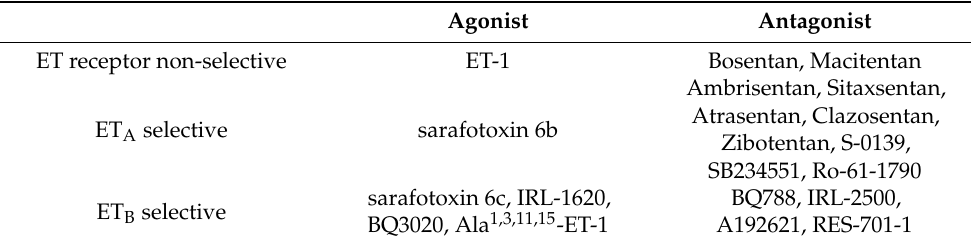
Agonist Antagonist